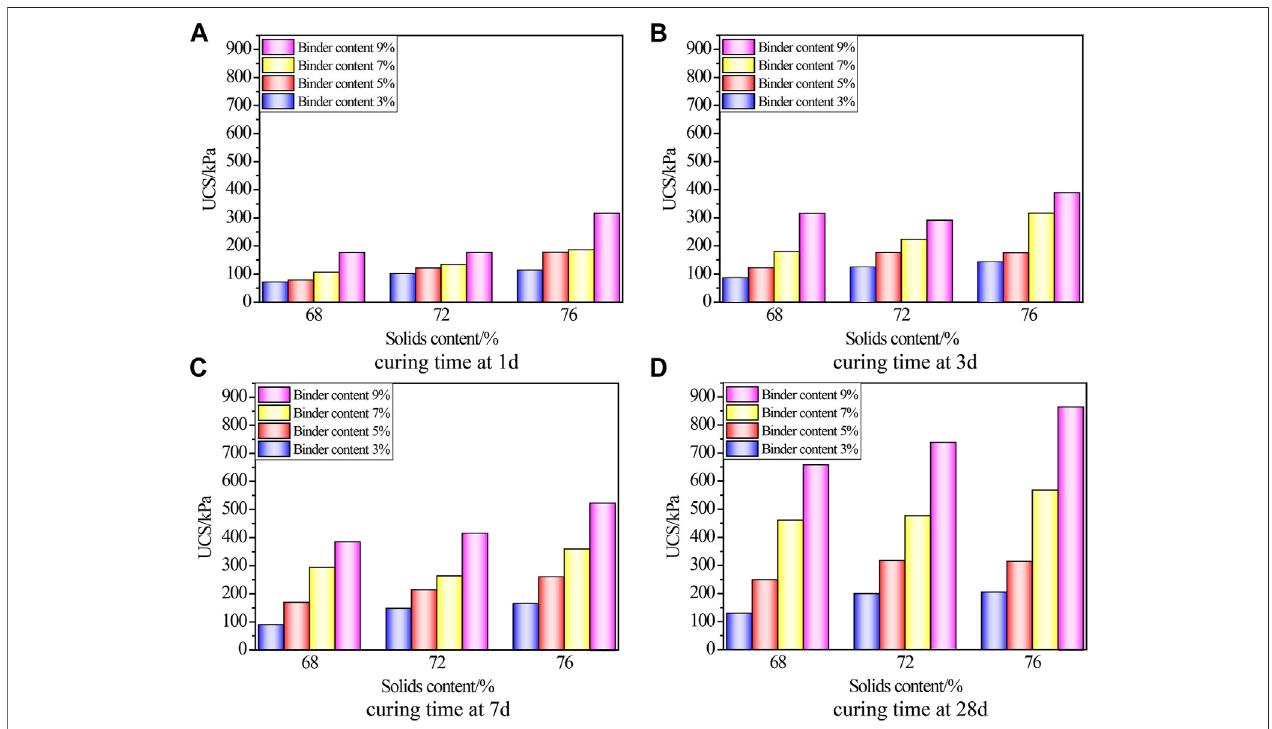
FIGURE 5 | The value of UCS corresponding to binder content under different cutting time.